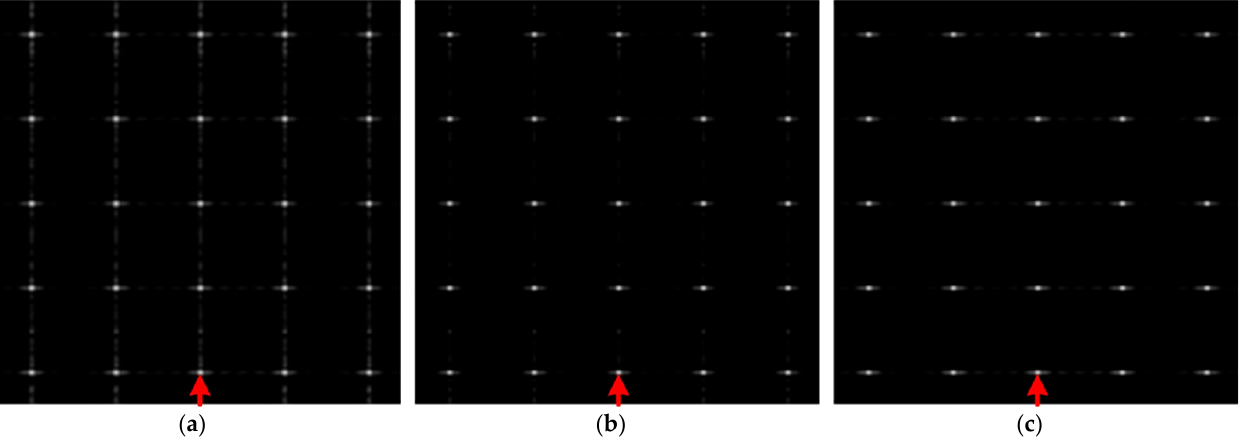
Figure 10. Illustration of the imaging results, where ( a – c ) are the results of the BP algorithm, the L1 algorithm, and the proposed algorithm, respectively.